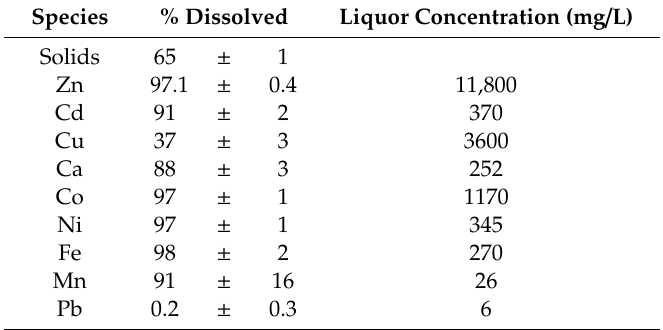
Table 5. Proportion of the metals dissolved during the leaching of the ZPR (Average ( ± standard deviation) of the results of three (3) leaching tests and the average composition of the liquor (Ratio L /